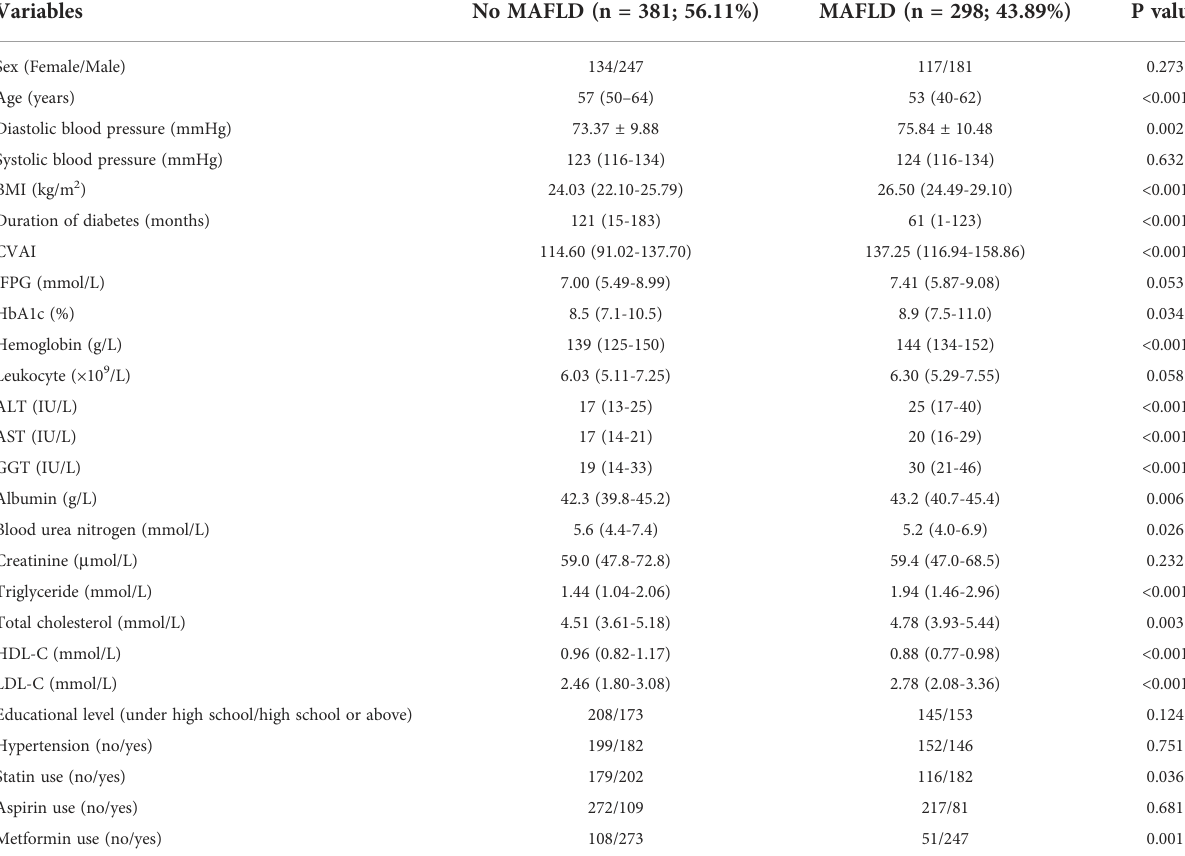
TABLE 1 Characteristics of Patients.